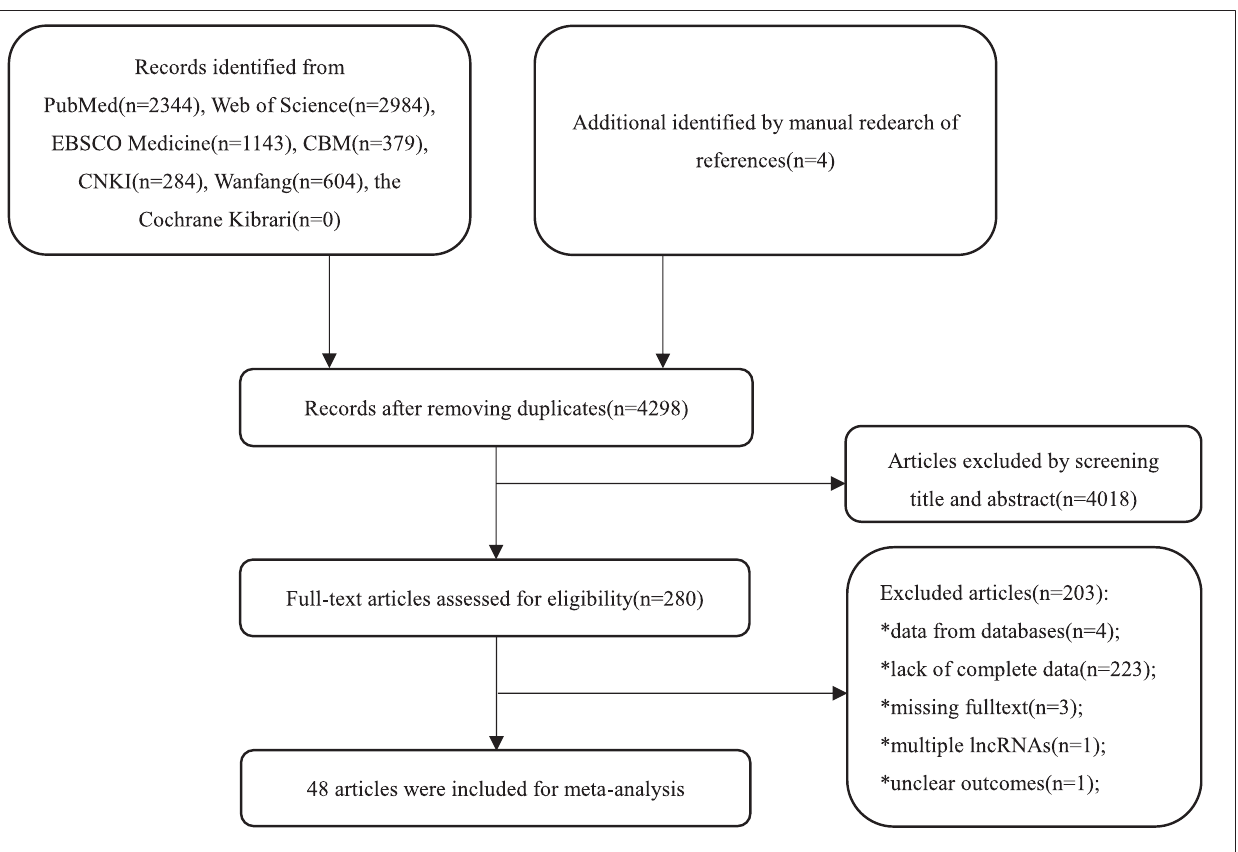
FIGURE 1 | The fl owchart of the